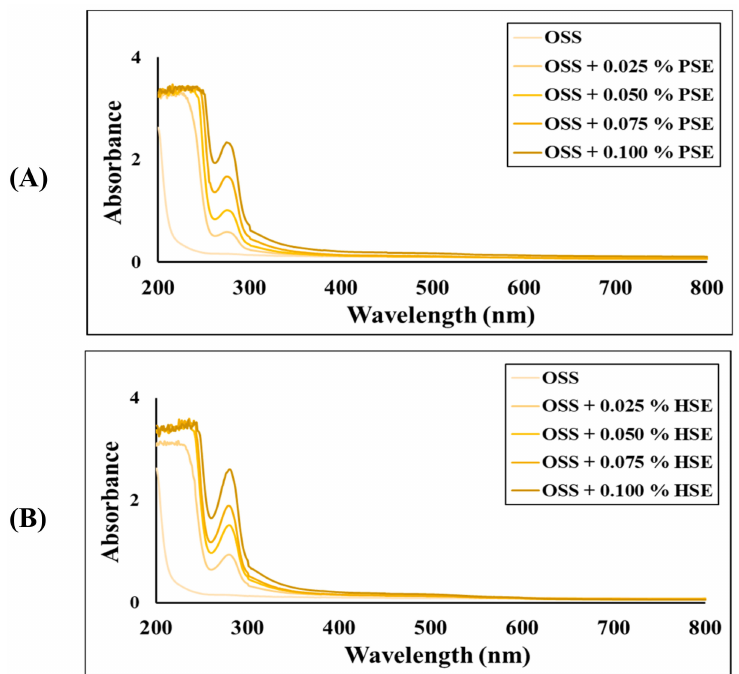
Figure 2. UV-vis absorption spectra of octenyl succinate starch films with pecan nutshell extract () ( A ), and octenyl succinate starch films with hazelnut skin extract () ( B ). OSS: Octenyl succinate starch, PSE: pecan nutshell extract, HSE: hazelnut skin